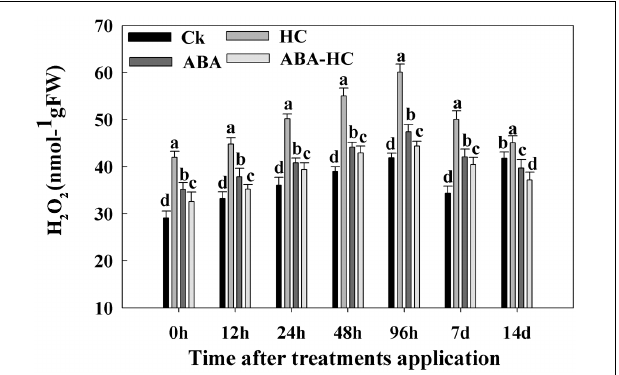
FIGURE 5 | Effect of HC, ABA, and ABA-HC on H 2 O 2 content in the buds of cv. ‘Shine Muscat’ treated with HC, ABA and AB-HC or control and sampled at 0, 12, 24, 48, 96 h, 7 and 14 days after treatement. Verticle lines above the means bars indicate standard error ( n = 3; p = 0.05) using Tukey’s HSD post hoc test. a–d represents significant difference between